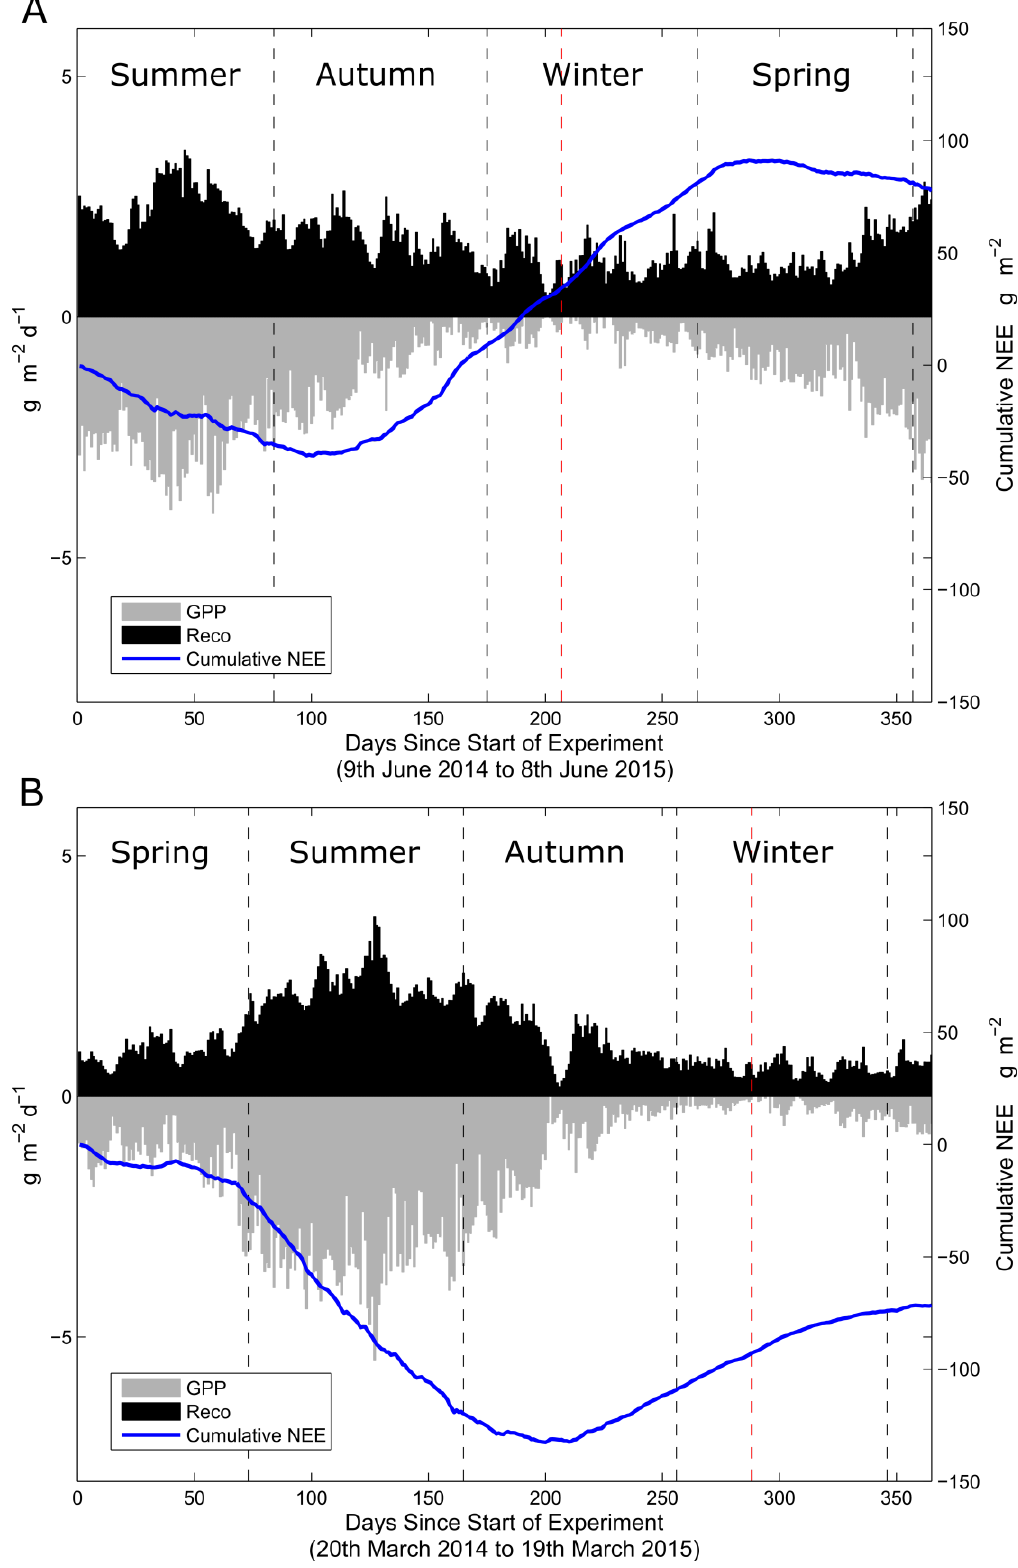
Figure 3. Daily GPP (grey) and R (black) flux from (A) Lonielist (restoration commenced in 2003/04) and (B) Talaheel (restoration commenced in 1997/98) during a full annual cycle, with cumulative NEE (blue) shown on the additional y-axis. Fluxes expressed as CO -C. Black dashed lines denote the seasons, while 2 the red dashed line marks 1 st January 2015. Different time periods are presented for each site due to the availability of equipment at each